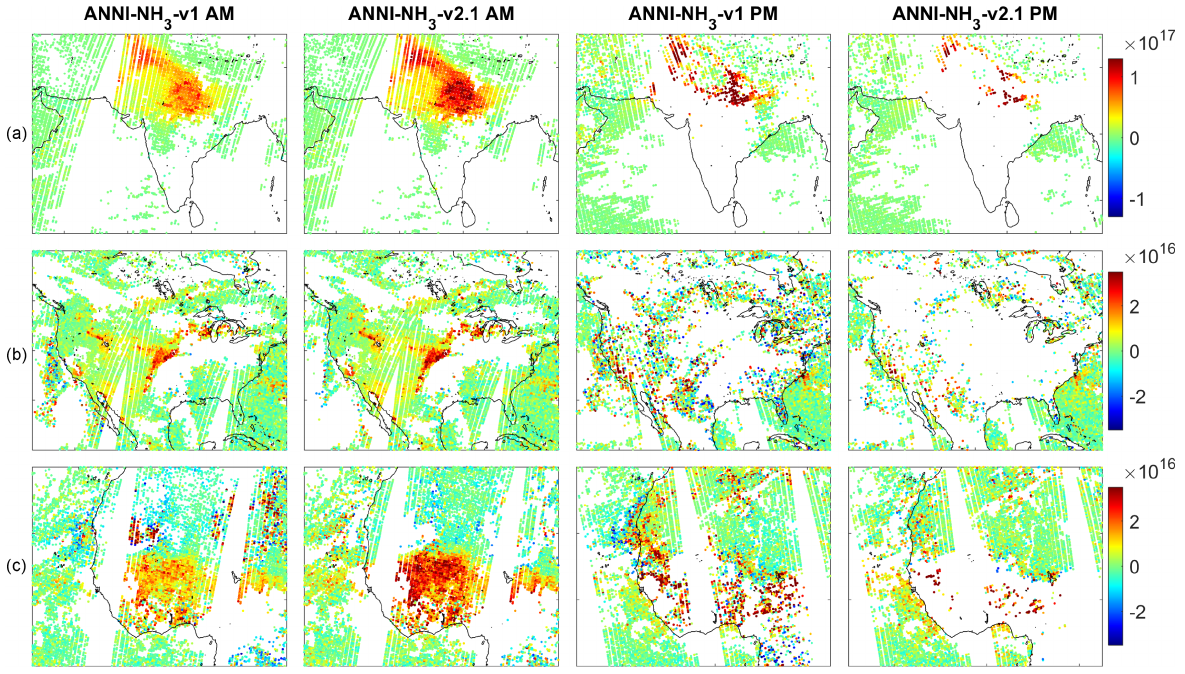
Figure 2. Example retrievals of the NH 3 column (moleccm − 2 ) on 17 June 2015 for ANNI-NH 3 -v1 (first and third column) and ANNI- NH 3 -v2.1 (second and fourth column), morning (AM, left two columns) and evening overpass (PM, right two columns), over south Asia (a) , North America (b) and the western part of north and central Africa (c)